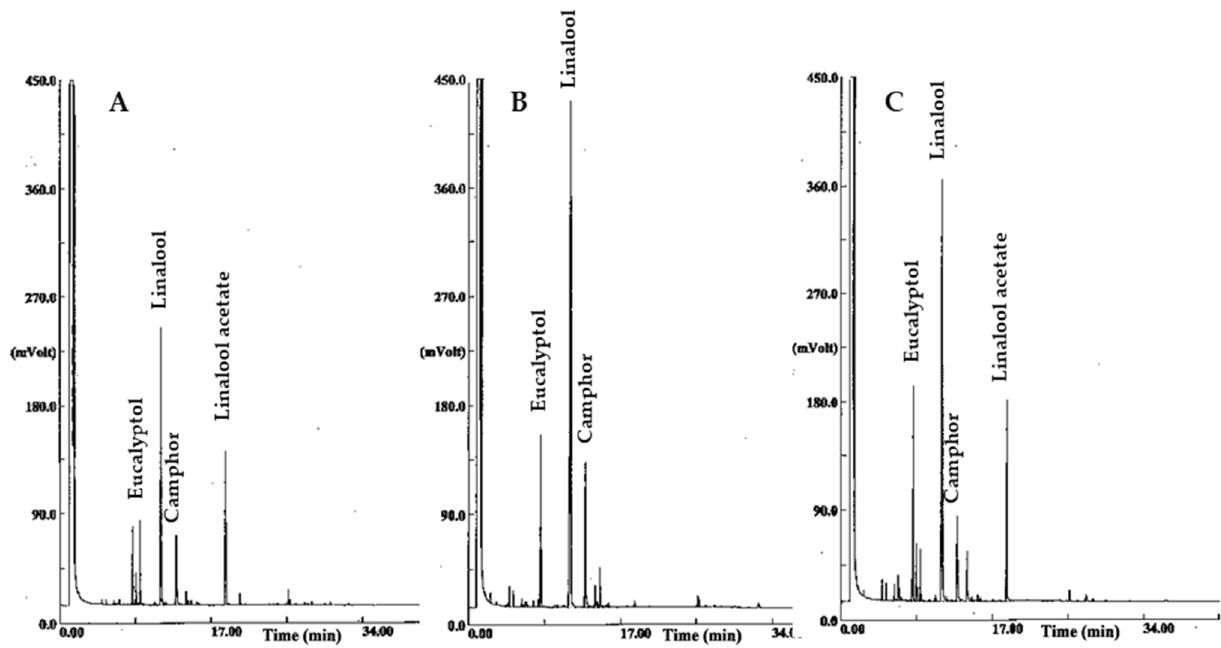
Figure 2. Gas chromatograms of EOs from lavandin cv Abrialis ( A ), Rinaldi Cerioni ( B ), and Sumiens ( C ). Major components are indicated.